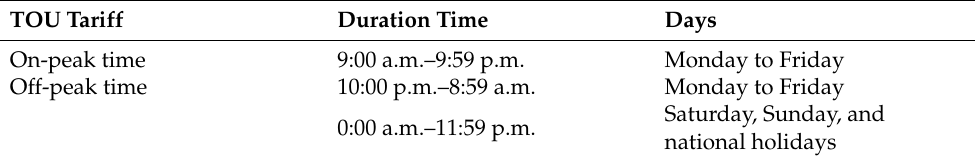
Table 3. PEA TOU